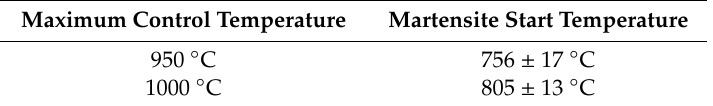
Table 3. Averaged martensite start temperature for maximum control temperatures of 950 and 1000 ◦ C for experiments carried out using a holding time of 10 s and a cooling rate of 100 ◦ C /